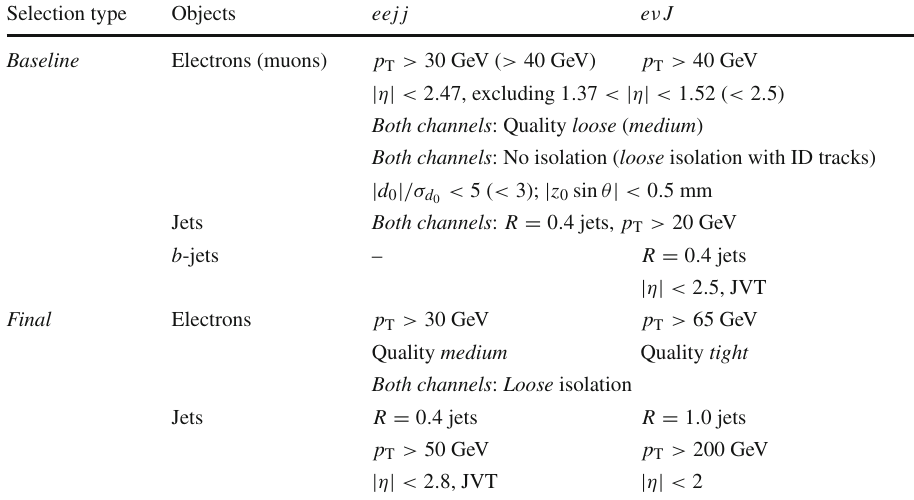
Table 1 Object definitions